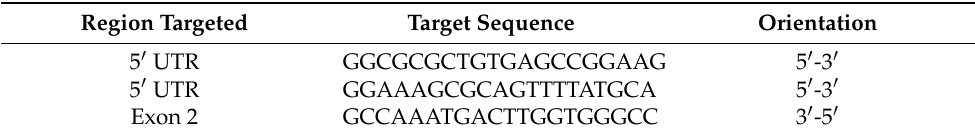
Table 1. List of target sequences of parla gene for sgRNAs generation. Region